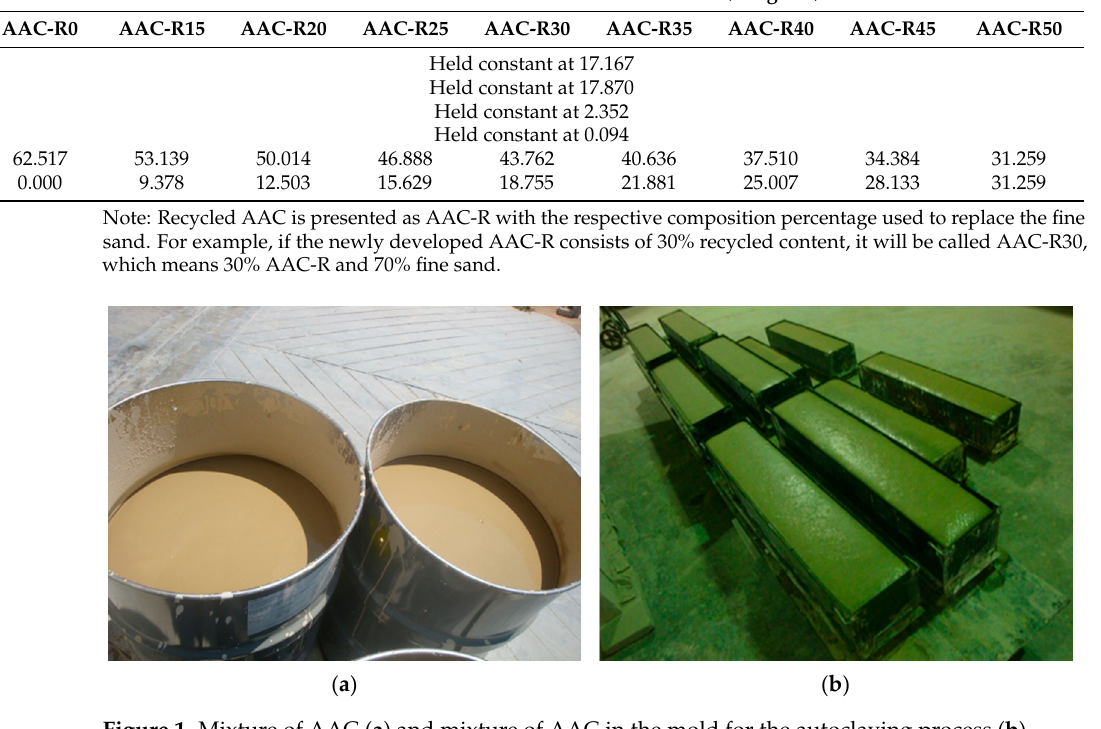
Figure 1. Mixture of AAC ( a ) and mixture of AAC in the mold for the autoclaving process ( b ). Table 1. Content of raw materials in AAC, showing the variations between the fine wet sand and the recycling powder (AAC-R).